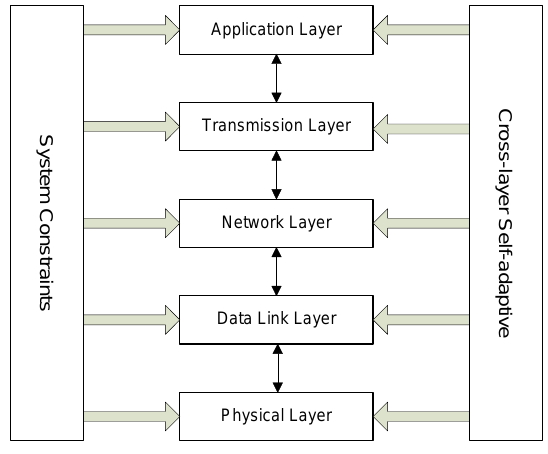
Figure 3. The architecture of cross-layer design.